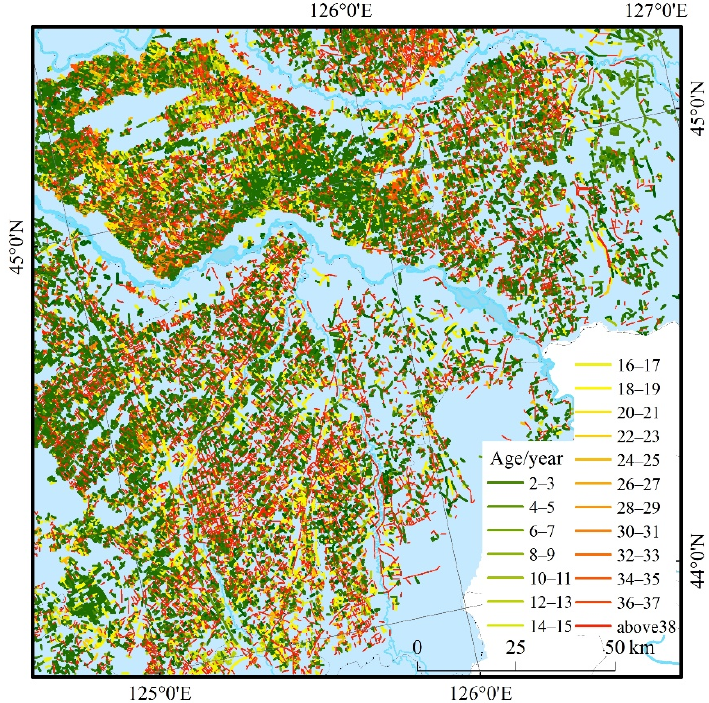
Figure 9. Identification result of farmland shelterbelt ages in 2020 in the study area.